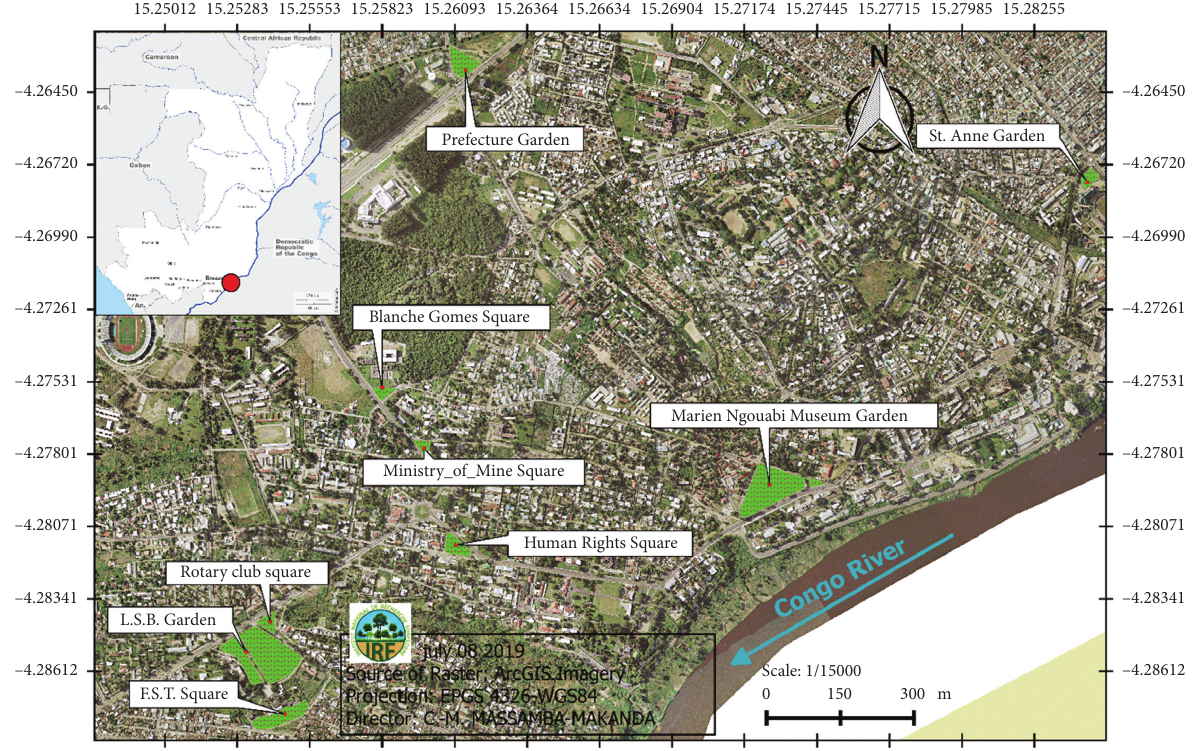
Figure 1: Location of green spaces within the Brazzaville urban